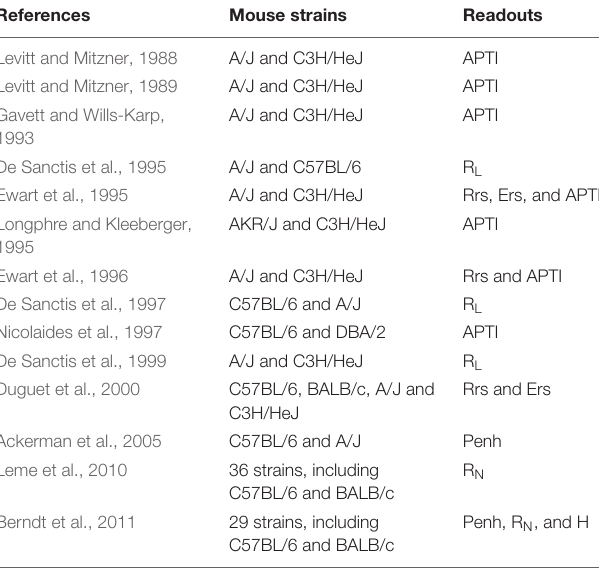
TABLE 1 | Innate degree of airway